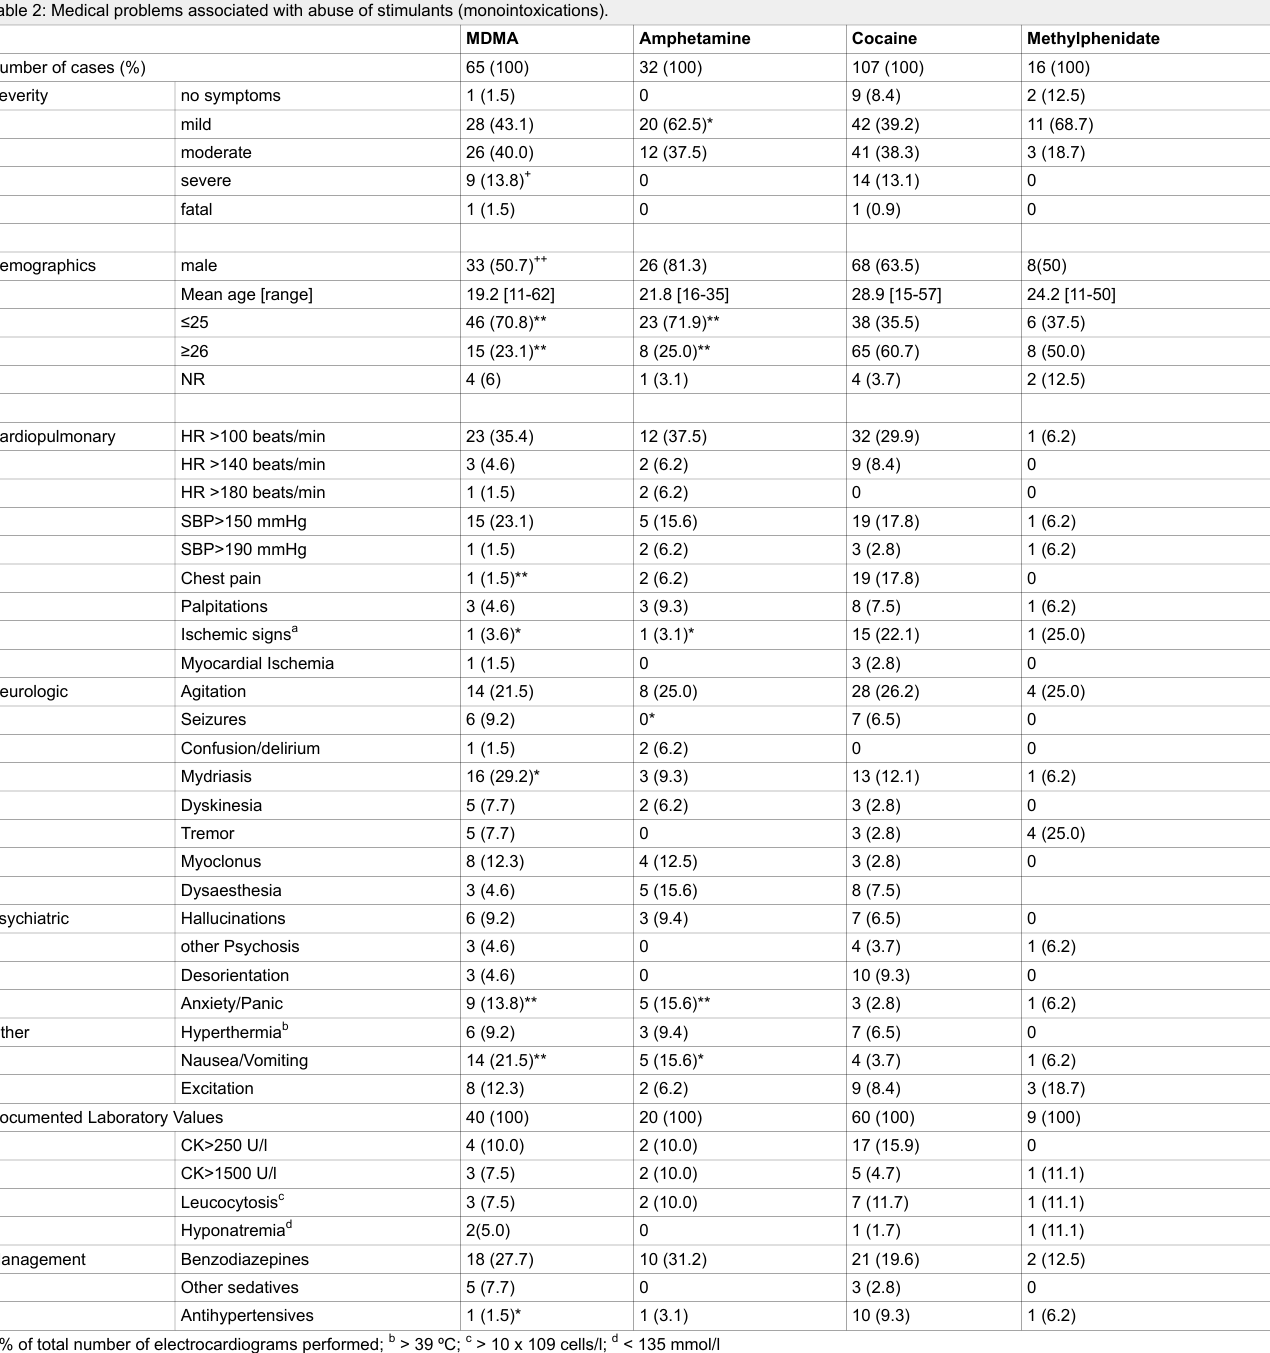
Table 2: Medical problems associated with abuse of stimulants (monointoxications).